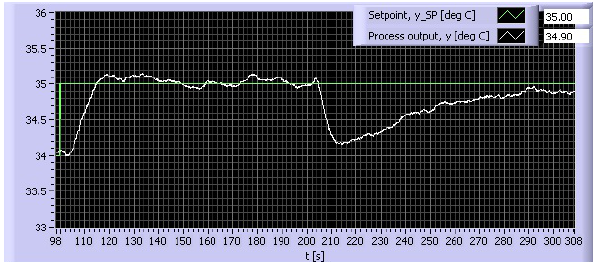
Figure 13: Tyreus-Luyben’s method: Responses in the control